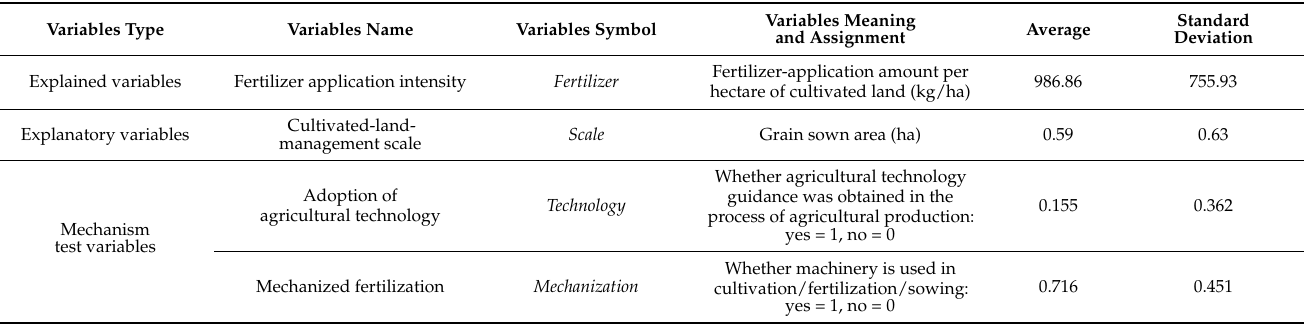
Table A2. Variables definitions and descriptive